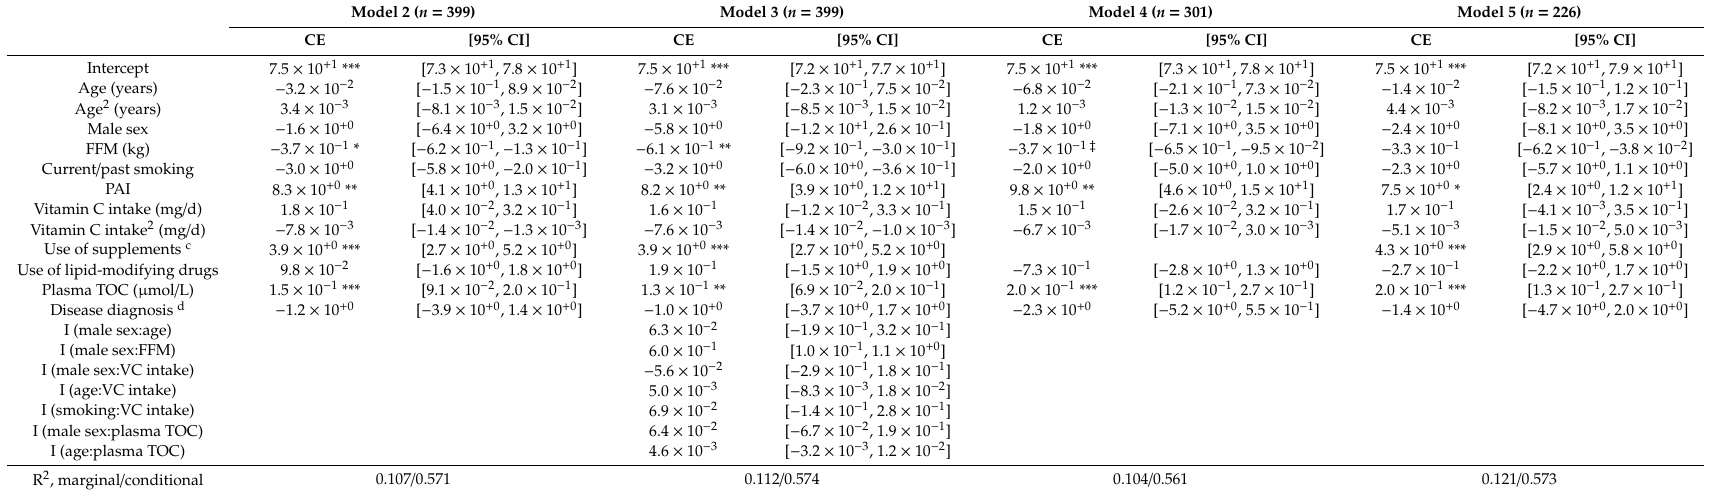
Table 2. Results of linear mixed-e ff ects models for determinants of plasma vitamin C concentrations a,b